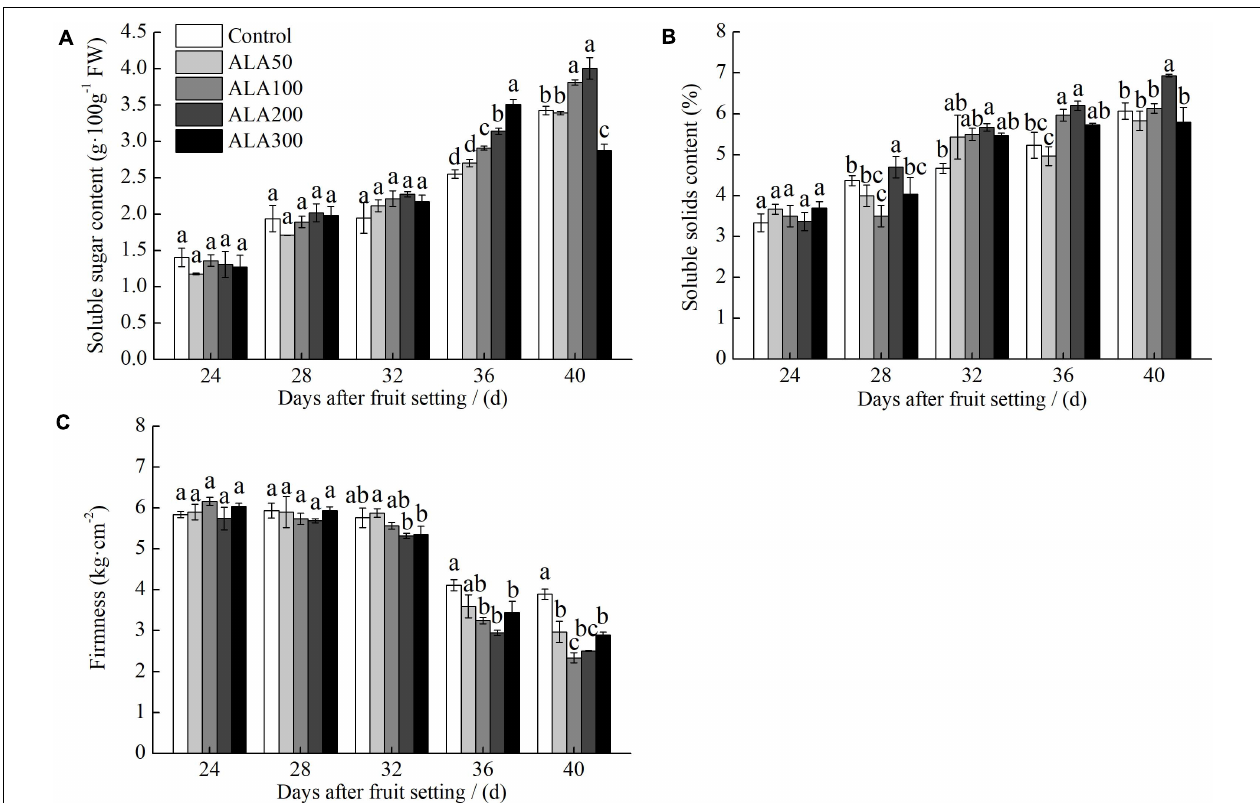
FIGURE 1 | The effects different concentrations of 5-aminolevulinic acid (ALA) on the soluble sugar, soluble solid content, and firmness of tomato fruit. (A) Soluble sugar content; (B) Soluble solid content; and (C) Firmness of tomato fruits at 24th–40th day after fruit setting under different treatments. Vertical bars represent mean ± SE from three independent replicates and the different letters denote significant differences ( p <